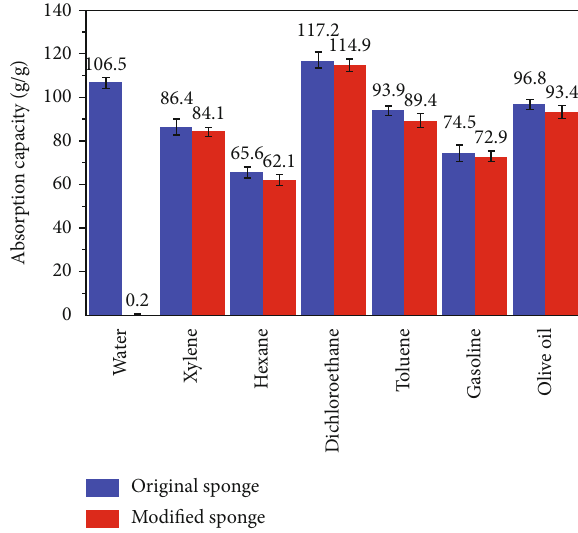
Figure 7: The absorption capacity of di ff erent liquids before and after modi fi cation.